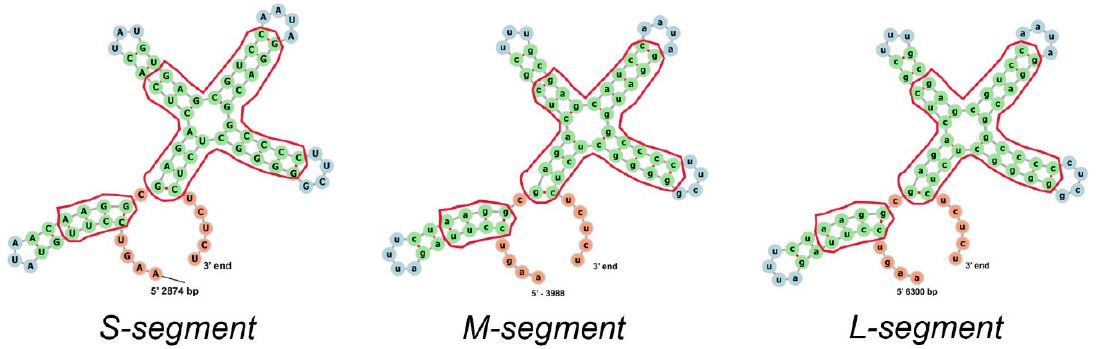
Figure 5. Predicted ssRNA secondary structure of terminal 75 bases at 3 (cid:48) end for three genomic segments. The region of similarity covers the last 75 nucleotides at the 3 (cid:48) end and starts with AAGU for all three strands. The structurally identical regions are boxed in red outlines. Note that even nonidentical nucleotides kept a similar secondary structure. The calculation was performed using the forna online RNA secondary structure visualization tool (http://rna.tbi.univie.ac.at/forna/, accessed on 17 August 2022). The sequence identity does not significantly affect recombination